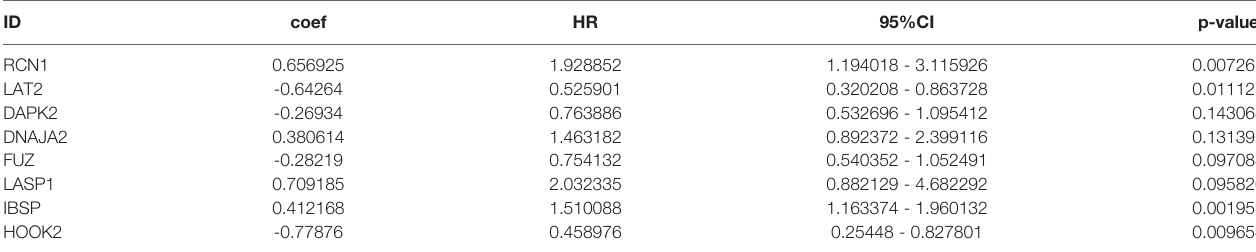
TABLE 2 | Prognostic characteristics of eight genes in the signature. ID coef